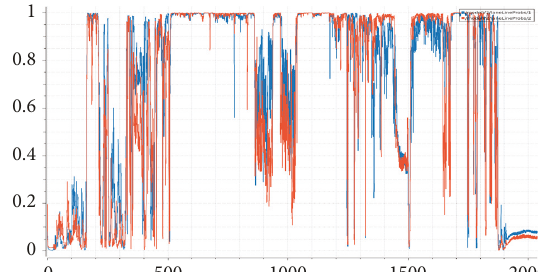
Figure 5: T1D1 steering degrees.